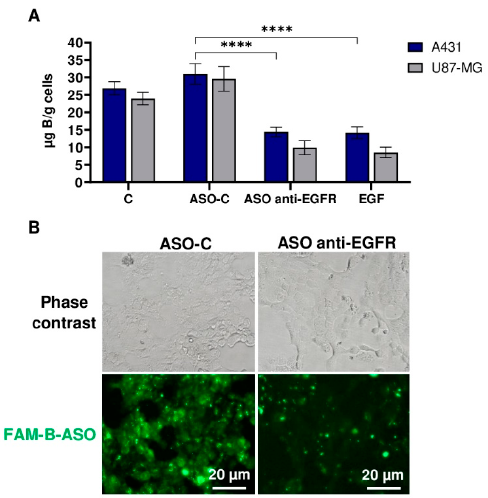
Figure 4. Boron-accumulation in A431 and U87-MG cells as a result of free uptake of B-ASO. In the first assay, the cells were transfected with ASO-C (non-active ASO) or ASO anti-EGFR (200 nM, respectively) in the presence of Lipofectamine 2000 [27]. After 36 h of incubation, the medium was replaced and cells were treated with B-ASO (80 pmol/well, free uptake). In the second assay free EGF ligand (10 ng/mL, 1 h incubation) was added to A431 and U87-MG cells to block B-ASO binding to EGFR. Then, the medium of the mixture was replaced with fresh medium and B-ASO (80 pmol/well, free uptake) was added. In both experiments, the cells were then incubated at 37 °C for 12 h and the concentration of boron in the cell lysates was measured using ICP MS. The means ± SEM (n = 3) are shown; **** p ≤ 0.0001. Figure was created in GraphPad Prism (https://www.graphpad.com/, accessed on 15 August 2022) ( A ). Representative fluorescence microscopy images of A431 cells transfected with ASO-C and ASO anti-EGFR (phase contrast) and FAM-B-ASO as described in panel A. Visualization of the green fluorescent FAM-B-ASOs was analyzed using fluorescence microscopy; (n = 3, bottom). All panels were magnified 20× ( B ).